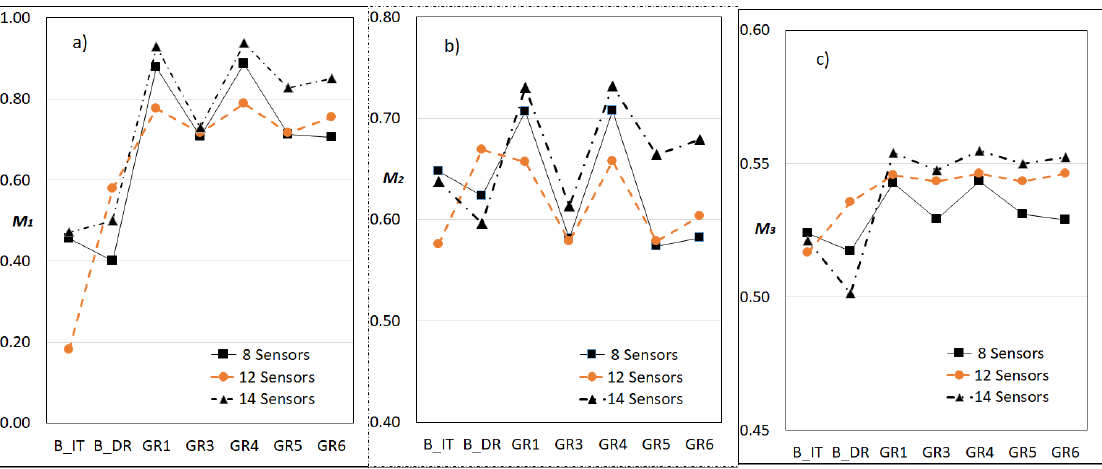
Table 4. Performance indicator values.